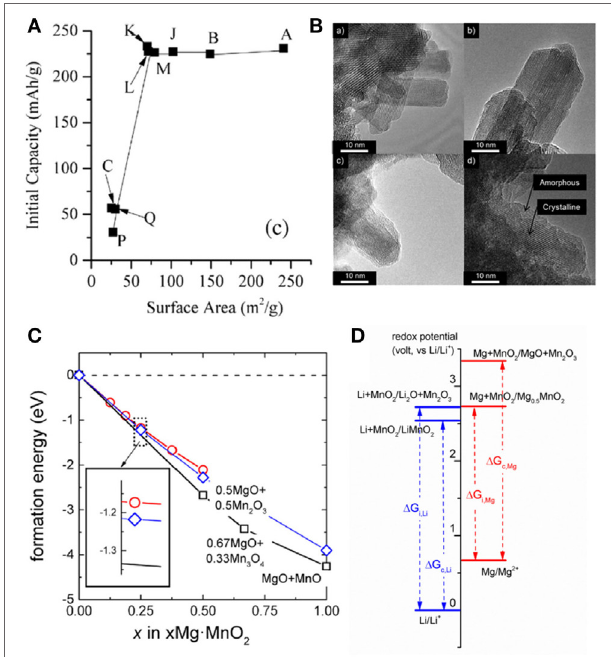
FigURe 2 | Reaction mechanism of MnO 2 in non-aqueous magnesium battery at super dry condition. (A) Capacity of different MnO 2 cathodes versus surface area of active material. Reprinted with permission from Zhang et al. (2015). Copyright 2015 Elsevier. (B) Surface amorphourization of α -MnO 2 cathode. Reprinted with permission from Arthur et al. (2014). Copyright 2014 American Chemical Society. (C) Reaction energy with the formation of intercalated compound (red), amorphous magnesium and manganese oxides (blue), and crystalline magnesium oxide and manganese oxides (black). (D) Energy diagram (unit: volt) for the magnesiation and lithiation of α -MnO 2 . Reprinted with permission from Ling et al. (2015). Copyright 2015 American Chemical